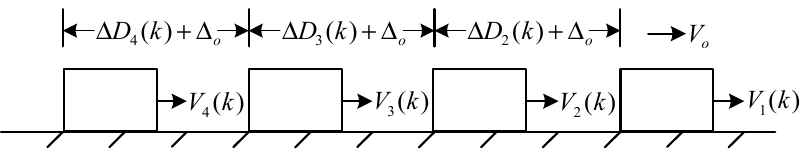
Figure 4. Intelligent unmanned vehicle platooning made up of four vehicles.